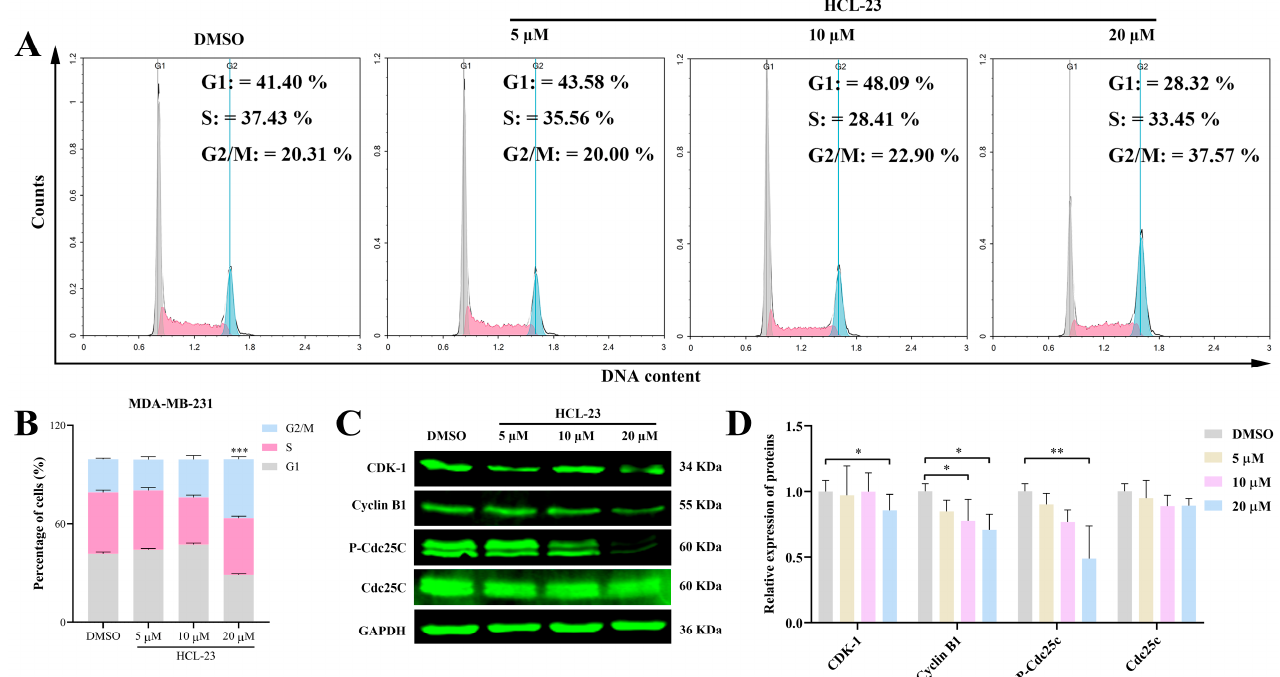
Figure 2. HCL-23 induces G2/M phase cell cycle arrest in MDA-MB-231 cells. ( A ) Cell cycle phase distribution of MDA-MB-231 cells treated with various concentrations of HCL-23 (5, 10, and 20 µ M) for 12 h. ( B ) Quantification of cell cycle distribution at G1, S, and G2 phases. ( C ) MDA-MB-231 cells were treated with various concentrations of HCL-23 (5, 10, and 20 µ M) for 12 h. Cell cycle-related proteins were analyzed by Western blot. ( D ) Quantification of cell cycle-related proteins. Data represent the mean ± SD of three independent experiments. * p < 0.05, ** p < 0.01, *** p < 0.001 vs. the DMSO